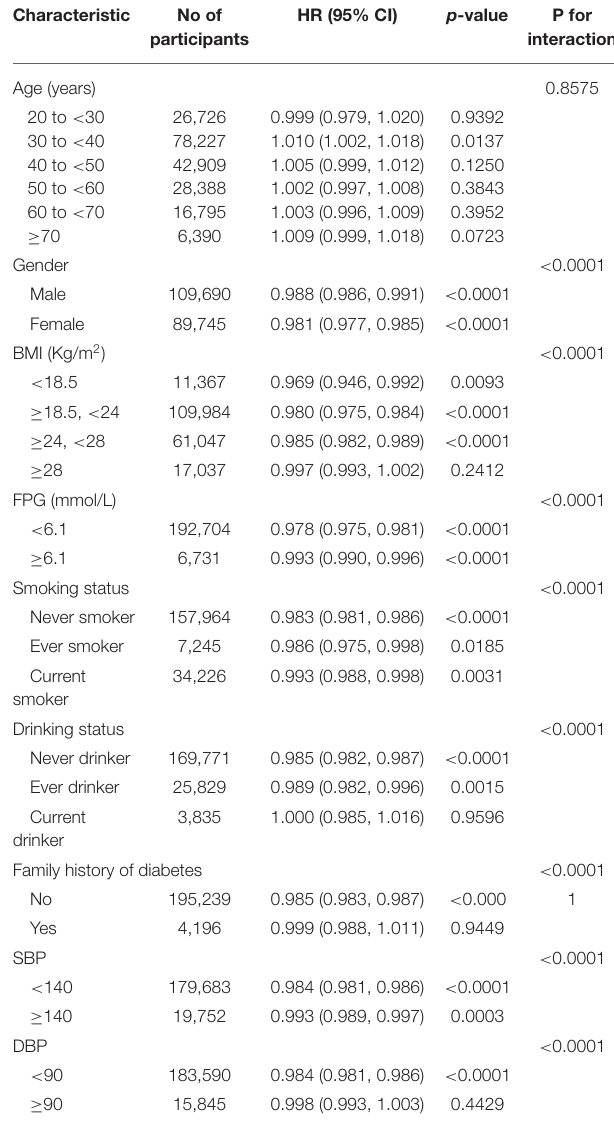
TABLE 6 | Effect size of eGFR on incident diabetes in prespecified and exploratory subgroups.